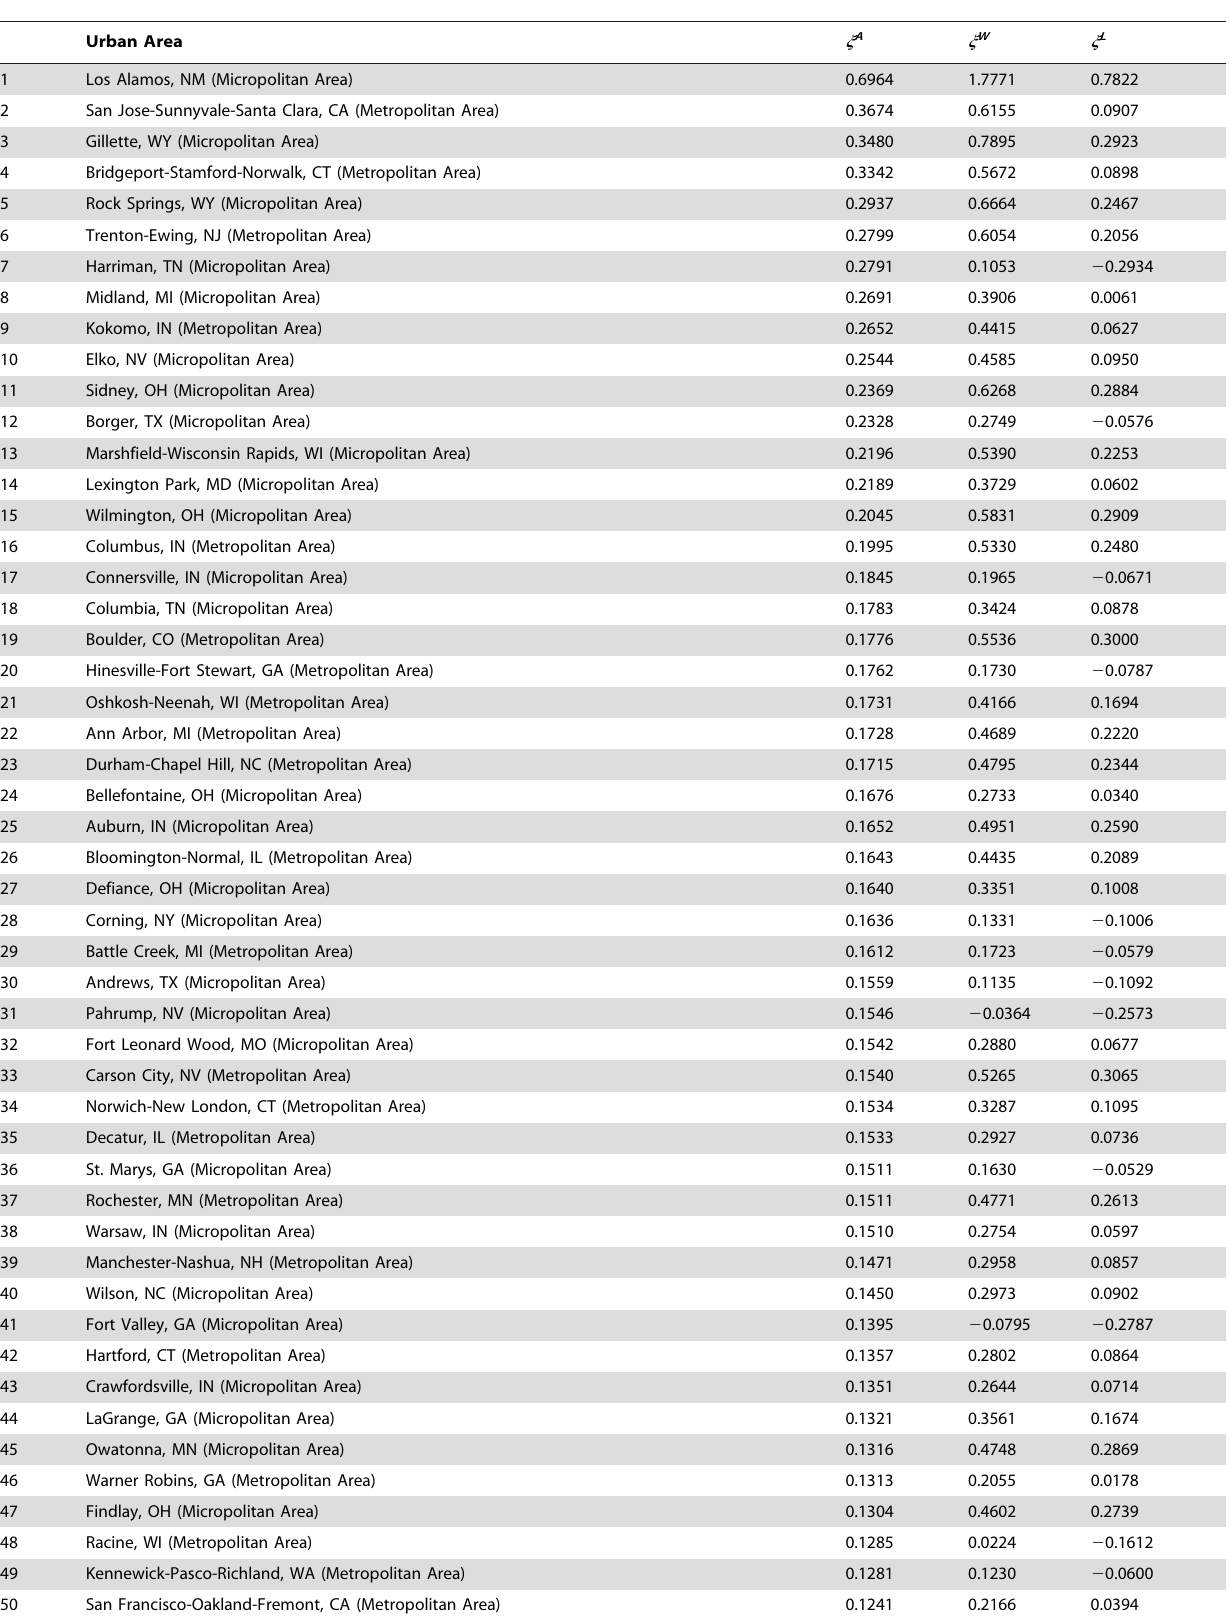
Table 1. Top 50 urban areas, ranked by their scale-adjusted measure of TFP ( j A ).